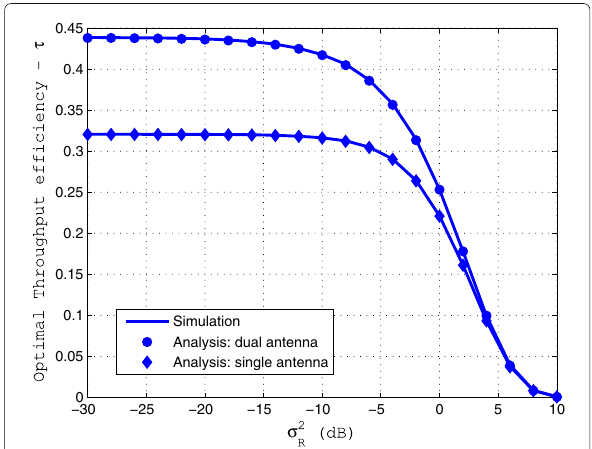
Fig. 9 The impact of residual self-interference on the throughput and in comparison with existing protocols in [27, 28] with γ 0 = 5 dB and m f = 1